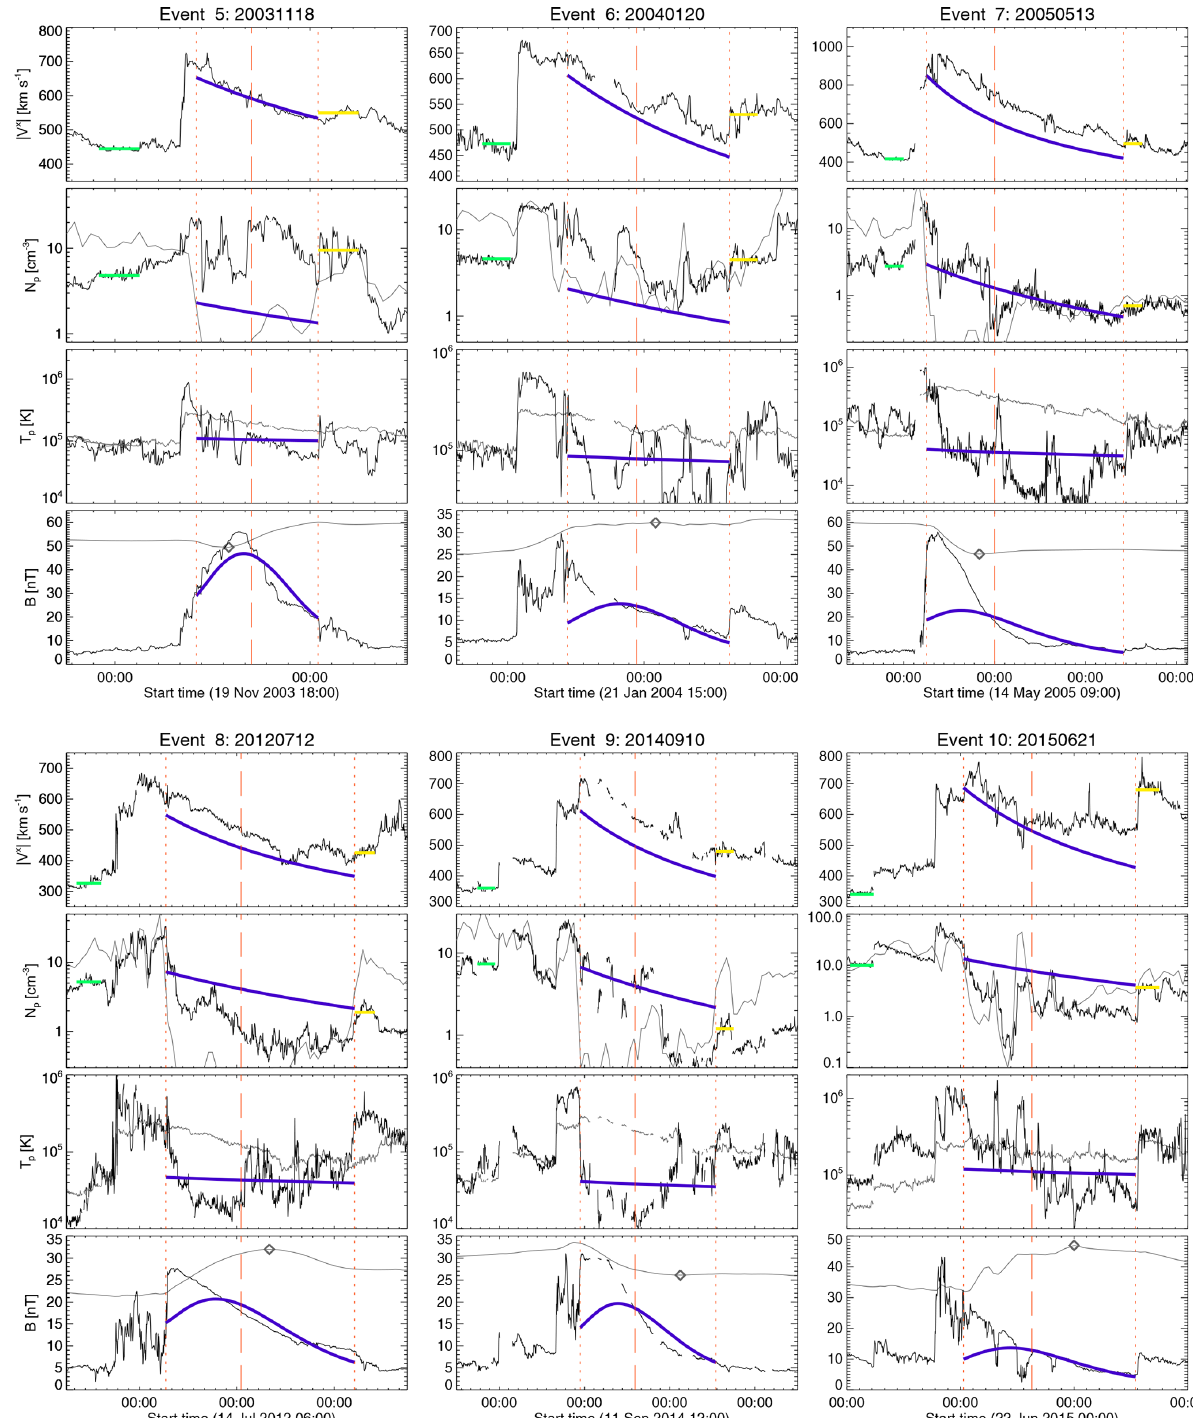
Figure 5. Calculated synthetic transit of Events 5 to 10. We present two rows with three columns each; and each column of four panels shows a different event. From top to bottom, the panels present the radial component of the solar wind speed ( | V x | ), the density ( N p ) and temperature ( T p ) of protons and the magnetic field intensity ( B ). Solid blue lines summarize our model results. Short-dashed and long-dashed vertical red lines mark the CME boundaries and center, respectively. Dotted red lines mark the CME boundaries. The solid (dotted) black lines are 5min (1h) in situ measurements from the OMNIWeb service. Green solid lines mark in situ solar wind used for calculations (see Table 1). The solid grey lines in the N p and T p panels are the plasma Beta (10 folded) and the expected proton temperature ( T exp ) (Lopez, 1987; Richardson and Cane, 1993, 1995), respectively. The solid grey line in B panel is the accumulative magnetic flux, as defined by Dasso et al. (2006), whose extremum (open diamond) gives an estimation for the magnetic center inside the